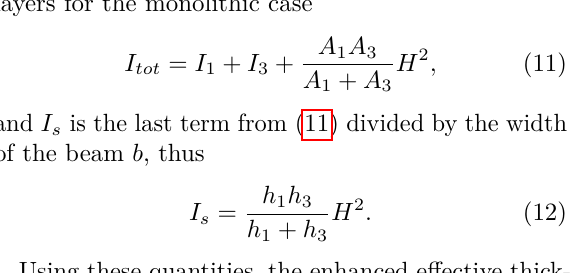
Table 1. The properties of laminated glass beams (GMM – Generalized Maxwell